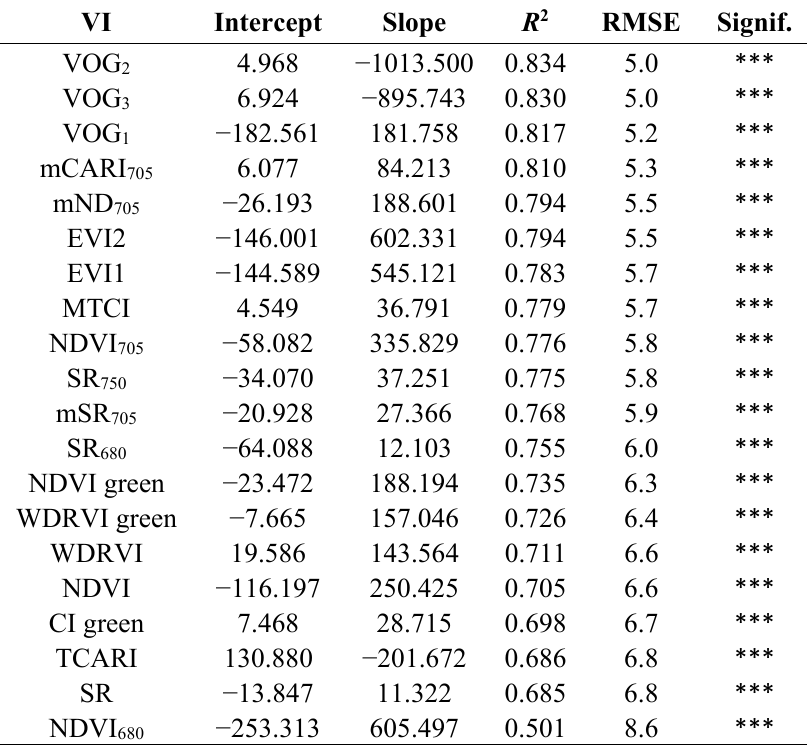
Table 6. Relationship between CC and VIs for C. erectus ( n = 136).